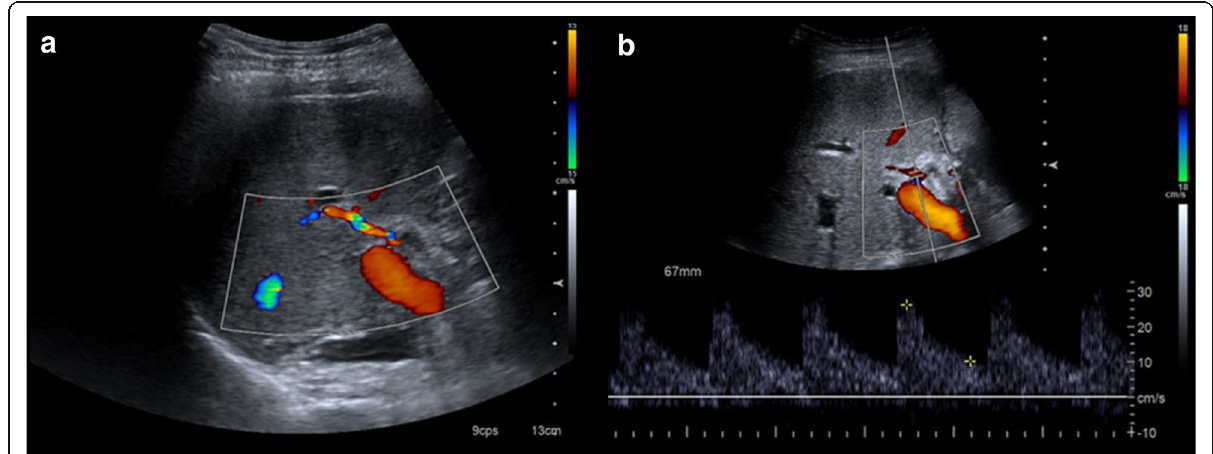
Fig. 3 a , b After treatment control. Control performed after thrombolysis and angioplasty of patient in Fig. 2. Normal arterial flow is seen. Resistive index shows normal values (0.6)